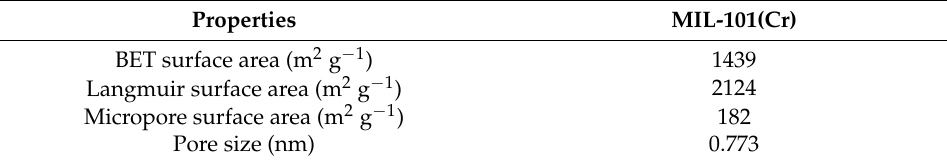
Table 1. Surface properties of MIL-101(Cr) metal-organic framework